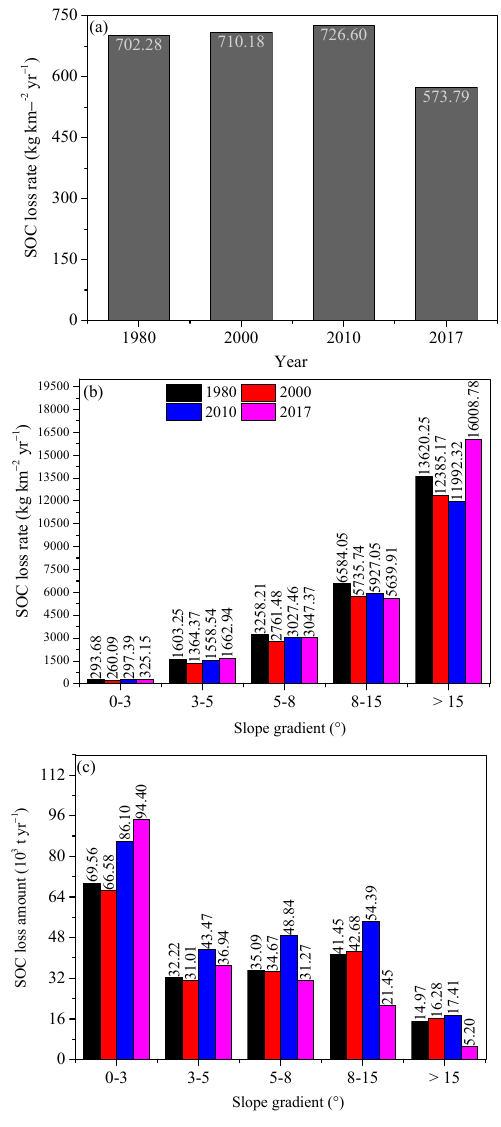
Figure 6. Annual soil organic carbon (SOC) loss rate in ( a ) the study region, ( b ) on different slope ranges, and ( c ) their SOC loss amount in 1980, 2000, 2010, and 2017.